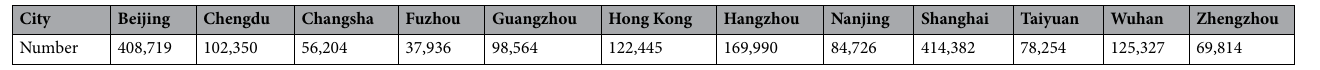
Table 3. Number of landmarks in experimental